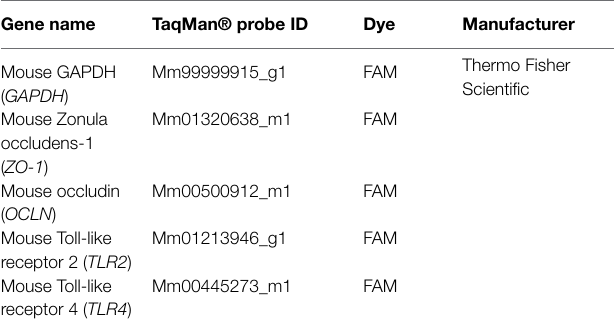
TABLE 2 | TaqMan probes for mouse